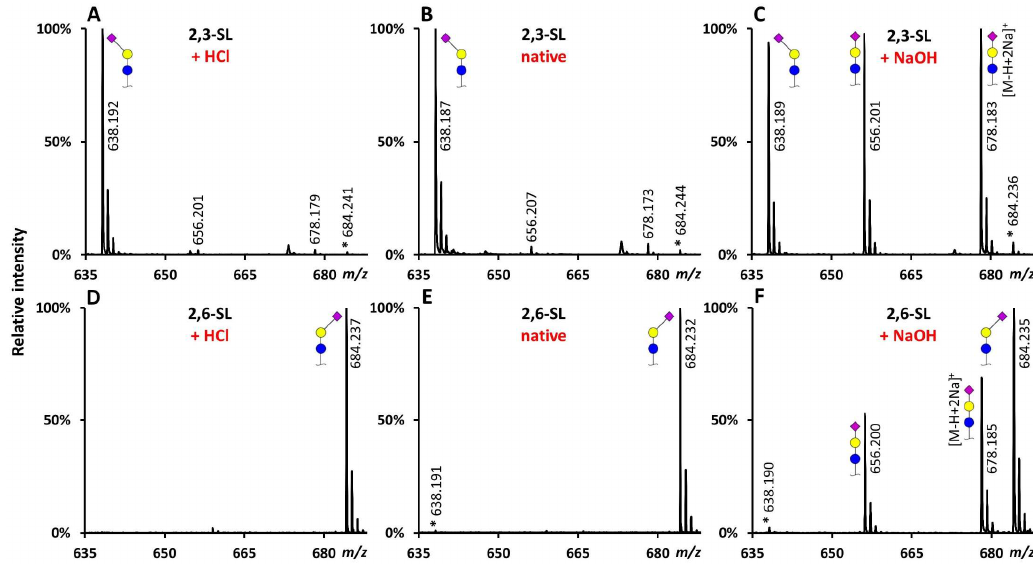
Figure 3. Representative MALDI-TOF-MS spectra of derivatized SL standards under different conditions using HOBt as catalyst. 2,3-SL ( A , B , and C ) and 2,6-SL ( D , E , and F ) incubated for 1 h at 37 °C in ethanol, with EDC and HOBt, at native ( B , E ) low ( A , D ) or high ( C , F ) pH. Lactonized reaction product: [M + Na] + = 638.190 Da, ethyl esterified reaction product: [M + Na] + = 684.232 Da. *: reaction product derived from misconversion of the standard (i.e., ethyl esterification of 2,3-SL or lactonization of 2,6-SL), standard impurity (reported purity: ≥ 98%), or a combination thereof. Symbols indicate the monosaccharide residues glucose (blue circle), galactose (yellow circle), and N -acetylneuraminic acid (purple diamond). In case of derivatized sialic acids, an α2,3-linkage is indicated by a left angle, an α2,6-linkage by a right angle, while non-derivatized sialic acids are depicted without an angle. Note: mass spectra are main peak normalized.